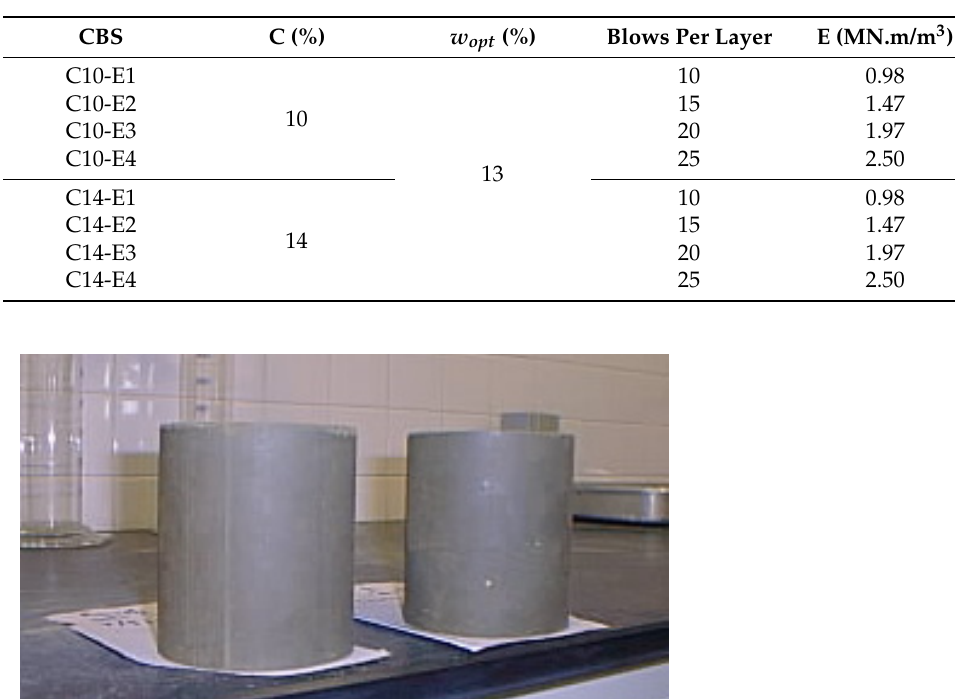
Table 3. Compaction of cement-bound soils.